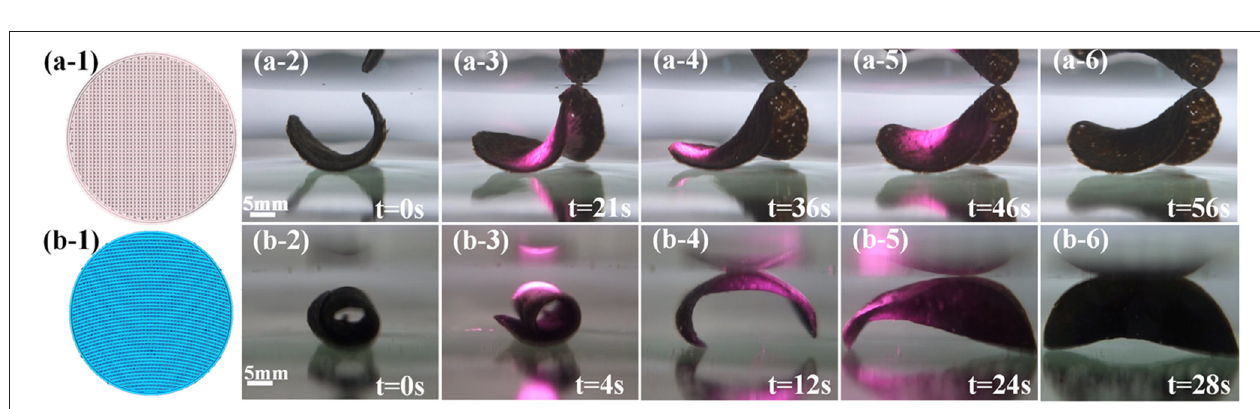
Figure 3 . Figure 3a-1 shows the structure pattern of Model